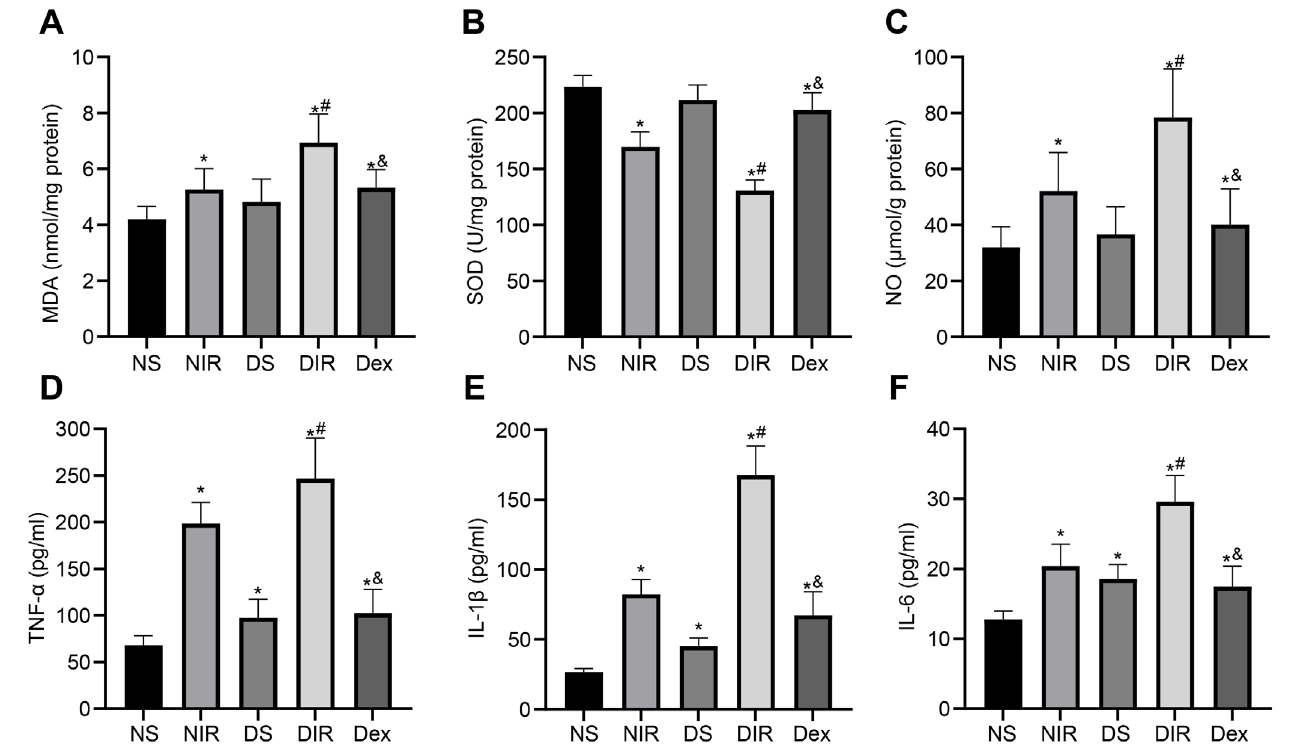
Fig. 4 - Dexmedetomidine (Dex) suppresses oxidative stress (oxygen radical) and inflammatory response in diabetic myocardial ischemia/ reperfusion-induced acute lung injury. A-C) Levels of oxidative stress indicators including malondialdehyde (MDA) (A), superoxide dismutase (SOD) (B), and nitric oxide (NO) (C) in lung tissues from each group after being treated by Dex for four weeks. D-F) Levels of pro-inflammatory factors including tumor necrosis factor-α (TNF-α) (D), interleukin (IL)-1β (E), and IL-6 (F) in lung tissues from each group after being treated with Dex for four weeks (n=6). One-way analysis of variance was employed to verify statistical significance. *P<0.05, compared with the non-diabetic sham (NS) group; #P<0.05, compared with the diabetic sham (DS) group; & P<0.05, compared with the diabetic + ischemia/reperfusion (DIR) group. NIR=non-diabetic +